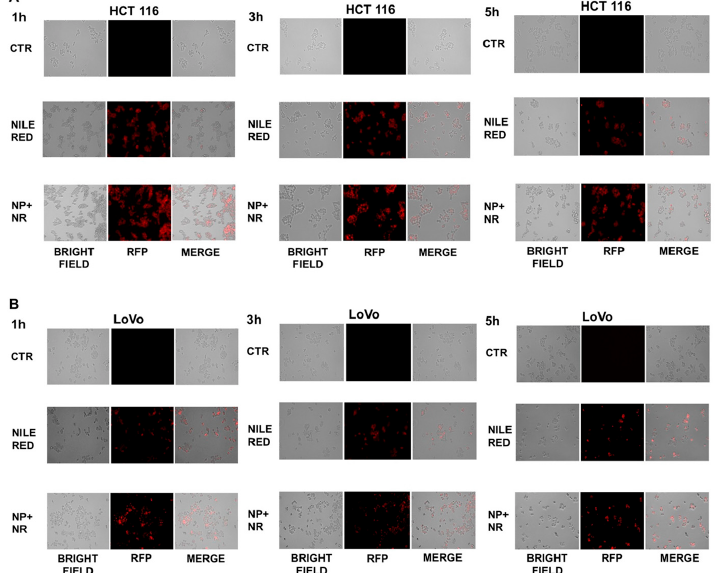
Figure 5. Fluorescence microscopy images of HCT 116 and LoVo, reported in panel ( A , B ) respectively,